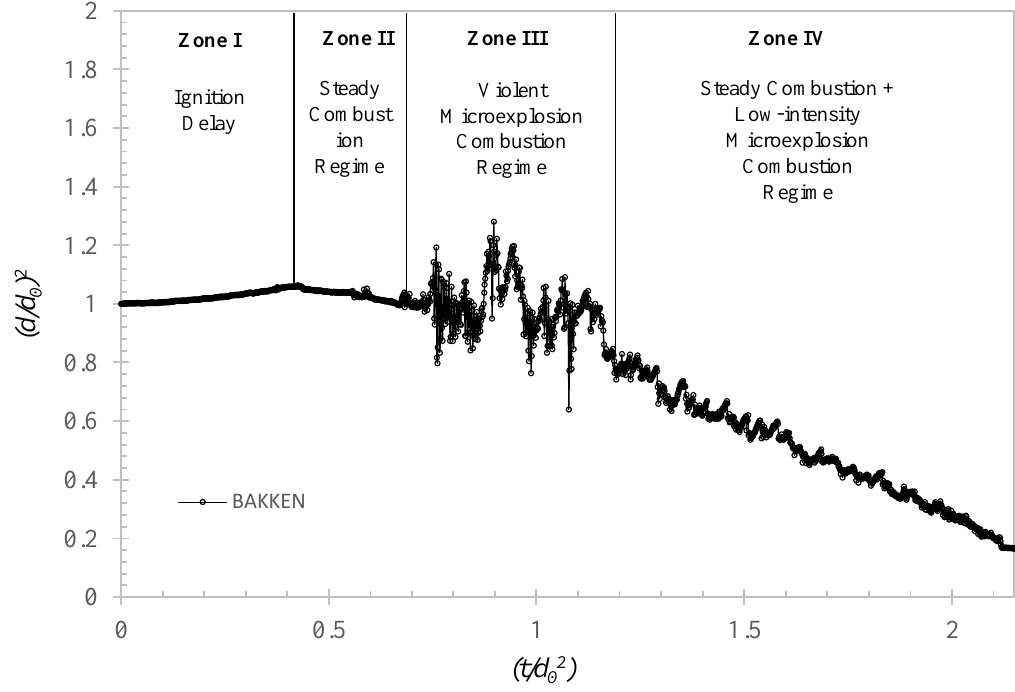
Figure 3. The evolution of (𝑑 𝑑 0 ⁄ ) 2 with time for Bakken crude oil with various combustion zones ( 𝑑 0 = 0.783𝑚𝑚) .